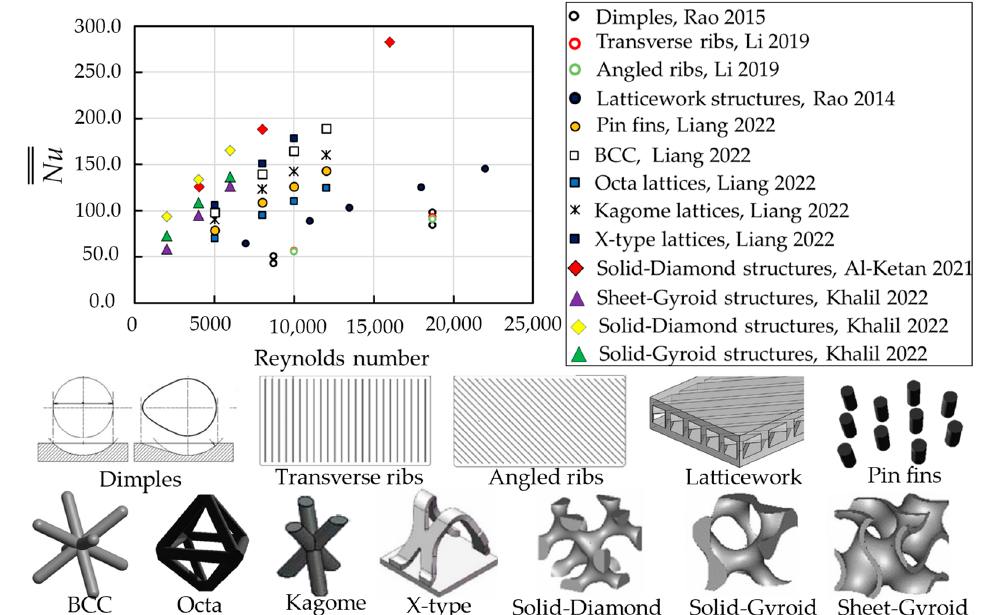
Figure 19. Comparisons of globally averaged Nusselt number of the TPMS structures with other cooling strategies. Dimples [86], Transverse ribs [87], Angled ribs [87], Latticework structures [88], Pin fins [13], BCC [13], Octa lattices [13], Kagome lattices [13], X-type lattices [13], Solid-Diamond structures [48,53], Sheet-Gyroid structures [48], Solid-Diamond structures [48], Solid-Gyroid structures [48].